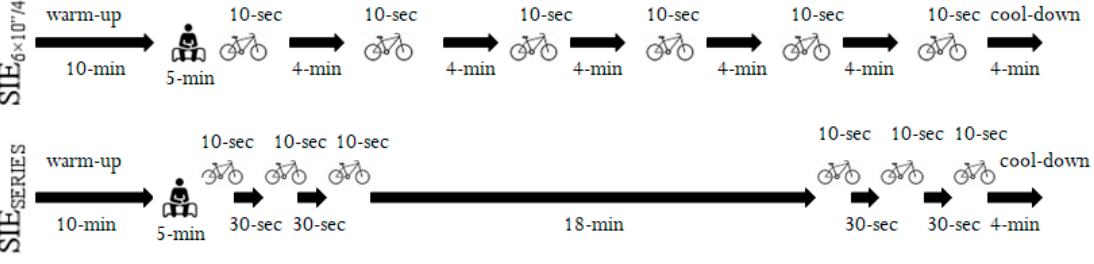
Figure 1. Cycling sprint interval exercise protocols split (SIE SERIES ) or not (SIE 6 × 10” / 4’ ) into series.